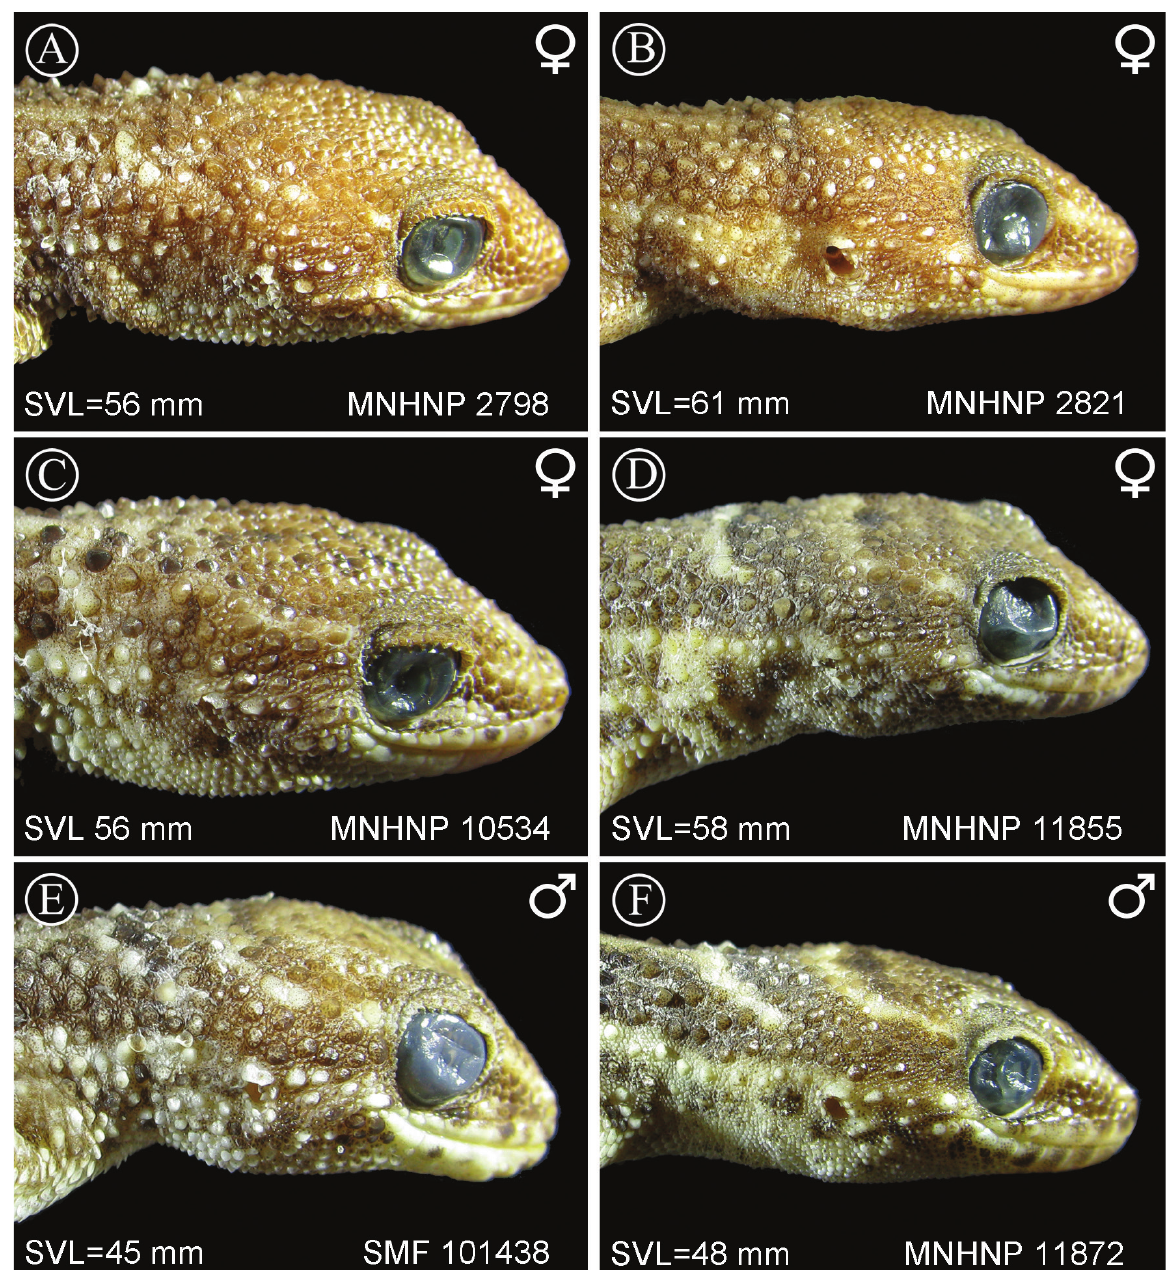
Figure 6. Plate showing the difference in scalation among individuals of similar sizes and same gender, of Homonota marthae ( A , C , E ) and H. septentrionalis ( B , D , F ). Note the more developed keeled tubercles on the sides of the neck in the former